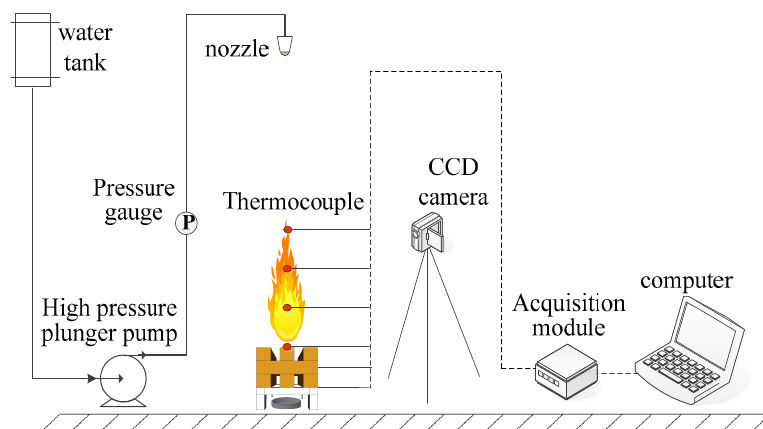
Figure 2. Experimental fire-suppression system